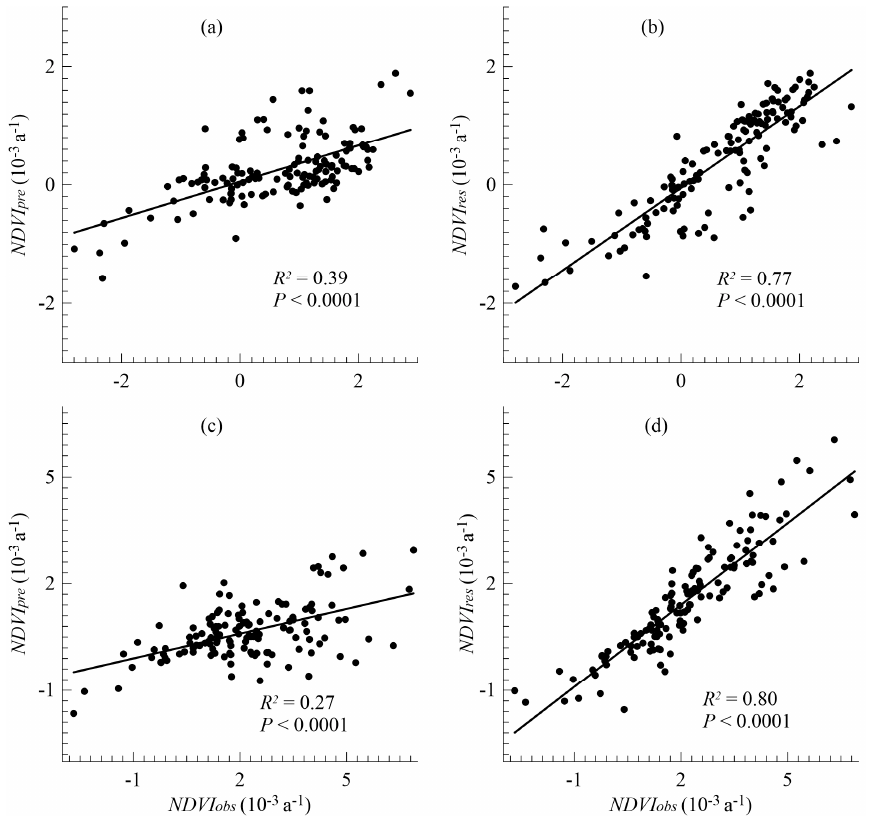
Figure 8. Scatter plots of the observed NDVI changes against the predicted NDVI (i.e., NDVI pre ) changes using the precipitation and temperature (left panel ( a , c )) and its residuals ( NDVI res , right panel ( b , d )) at the prefecture level from 1982 to 2003 (top panel ( a , b )) and from 2003 to 2019 (bottom panel ( c , d )).